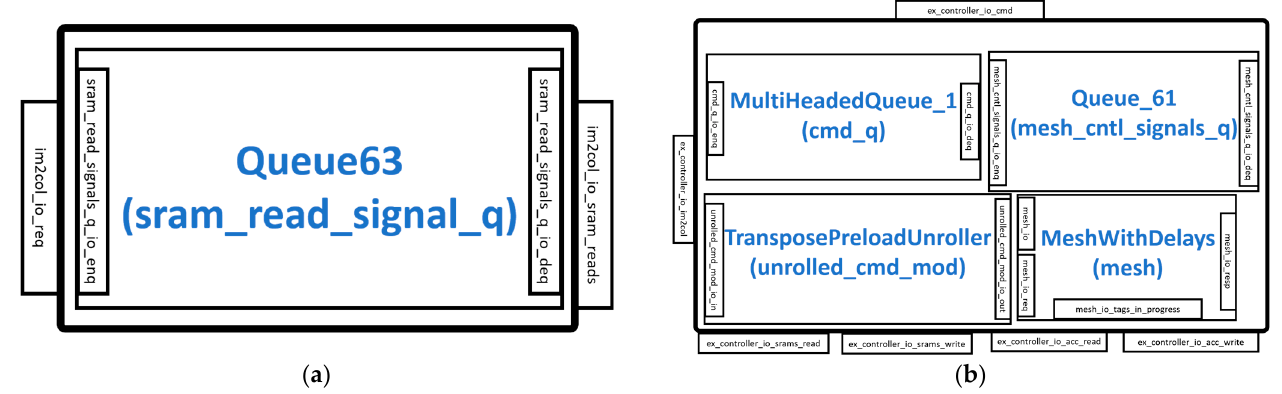
Figure 6. SRAM controllers: ( a ) im2col module; ( b ) ExecuteController module.